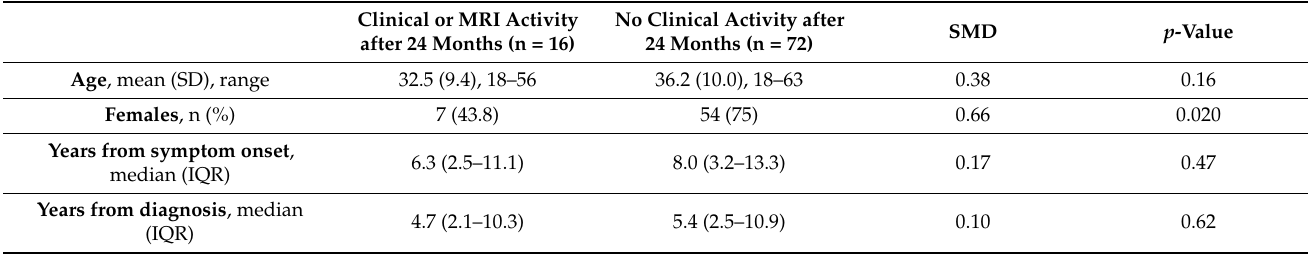
Table 2. Clinical characteristics in patients with and without clinical or MRI activity after 24 months from treatment